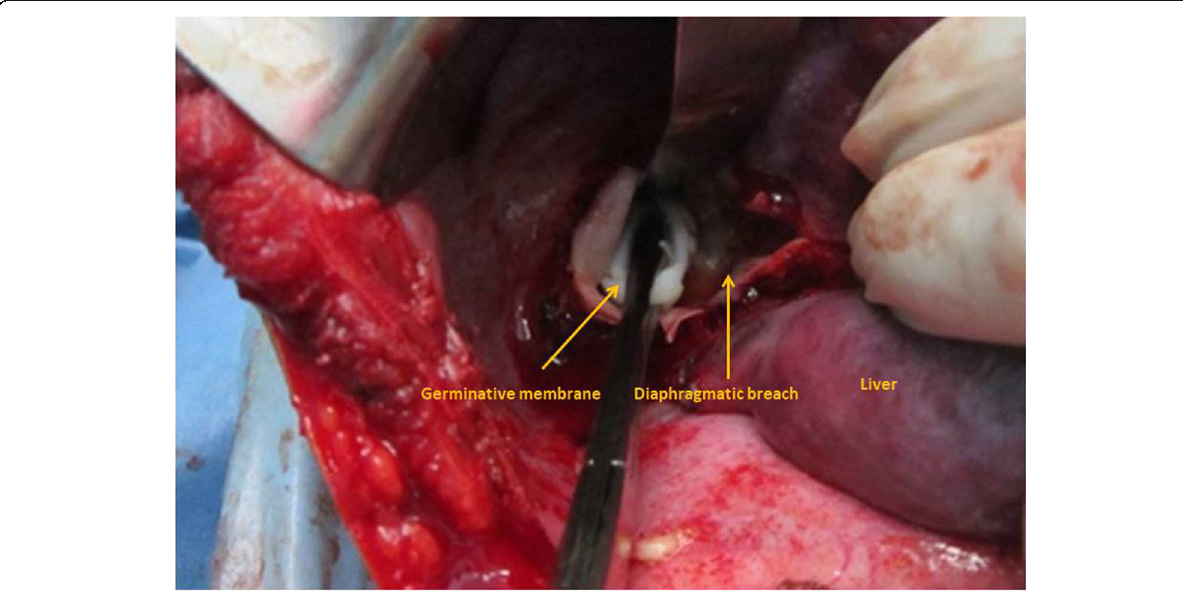
Fig. 2 Surgical specimen revealing an hydatid cyst on the hepatic dome and a 3-cm large diaphragmatic breach through which germinative membrane disseminated to pleural